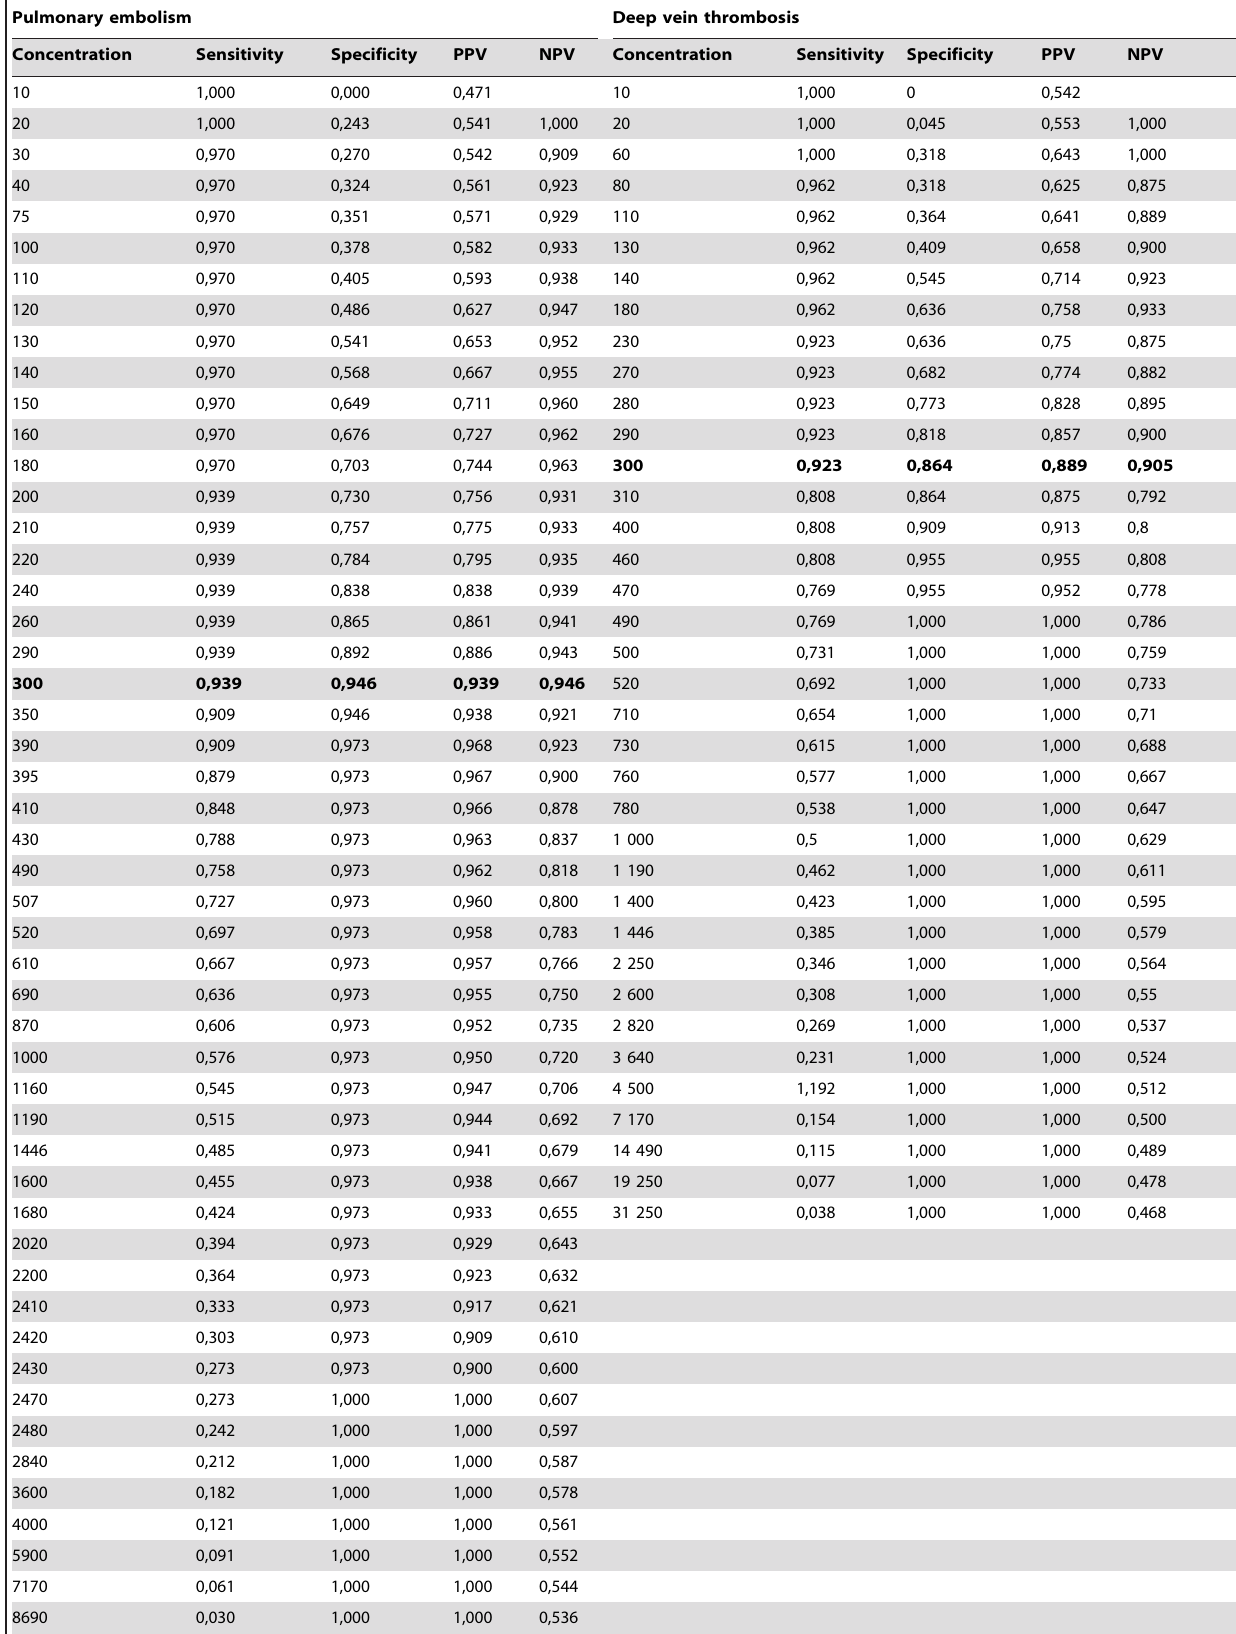
Table 2. Roc appendices for pulmonary embolism and for deep vein